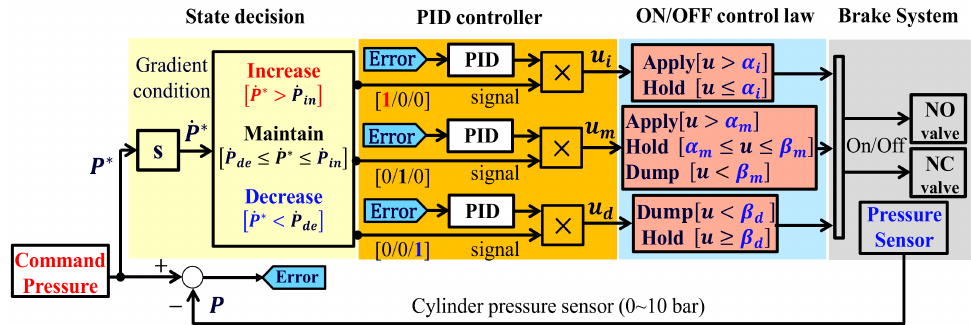
Figure 8. Proposed pressure control method with conditional operating